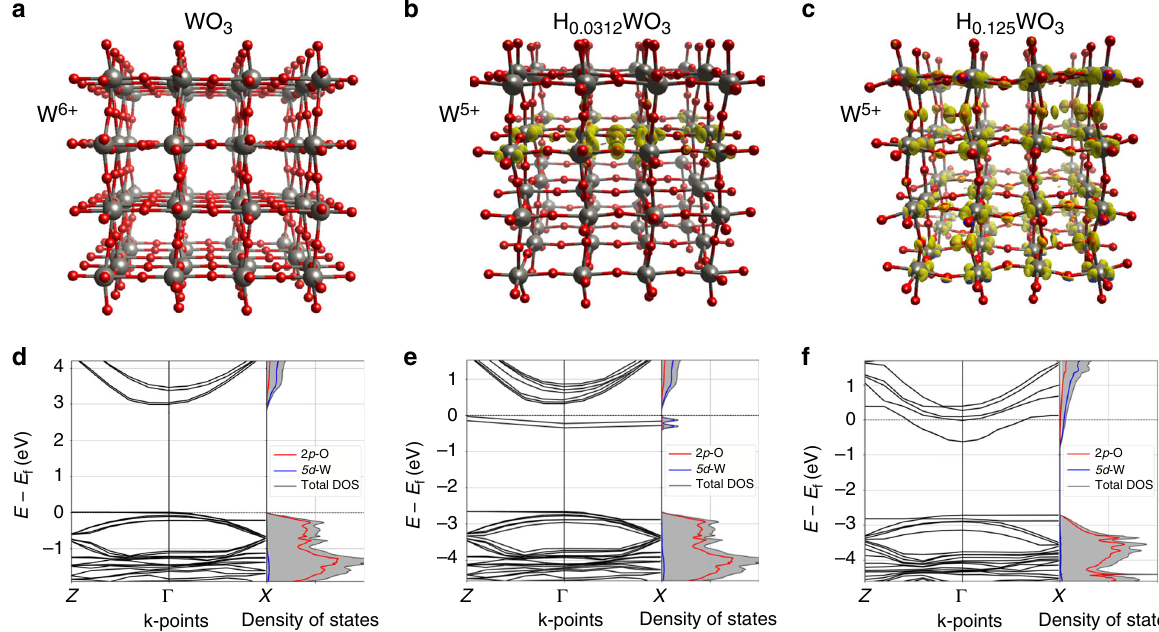
Fig. 5 Calculated electronic structure with protonation in WO 3 . Crystal structures, charge density maps and corresponding electronic band structure and density of states for ( a , b ) WO 3 , ( c , d ) H 0.0312 WO 3 , ( e , f ) H 0.125 WO 3 ; grey atoms — W, red — O and white — H. The excess charge associated with the H insertion is shown in yellow (isosurface – 0.04 e/Å 3